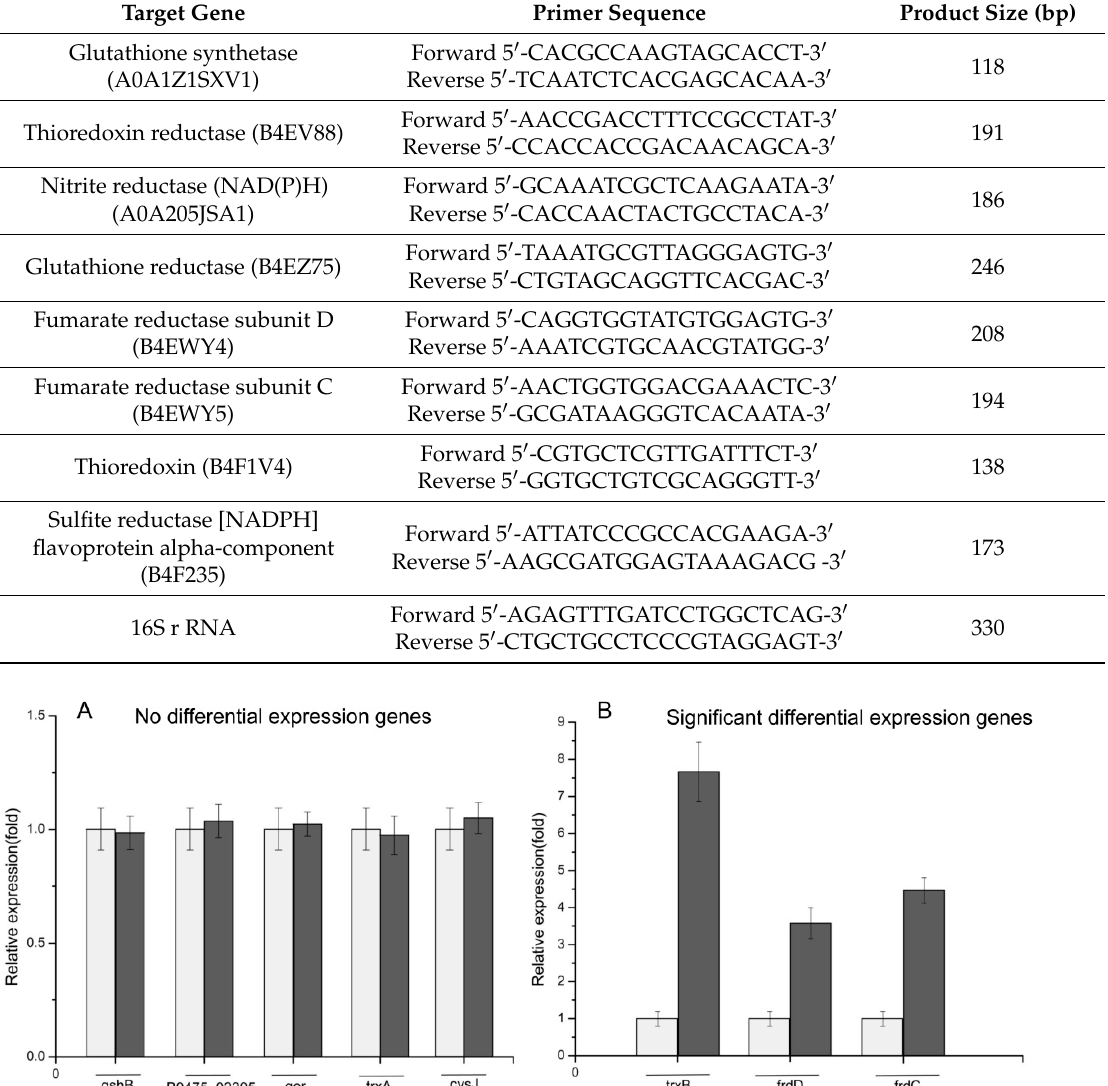
Figure 9. Transcript levels of selected genes quantified by Real-time PCR. ( A ) Non-differentially expressed genes; ( B ) significant differentially expressed genes. Data are shown as fold changes by calculating transcript levels of selenite treated samples compared to untreated (defined as 1). Data represent an average of three biological replicates ± SD. Table 2. Primers for targeting genes.